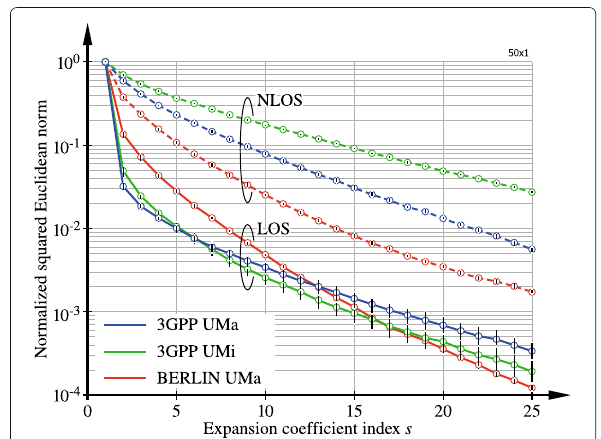
Fig. 4 Angular-domain compressibility of the channel matrices obtained with the Q UA DR I G A channel model. Blue: 3GPP UMa; green: 3GPP UMi; red: BERLIN UMa